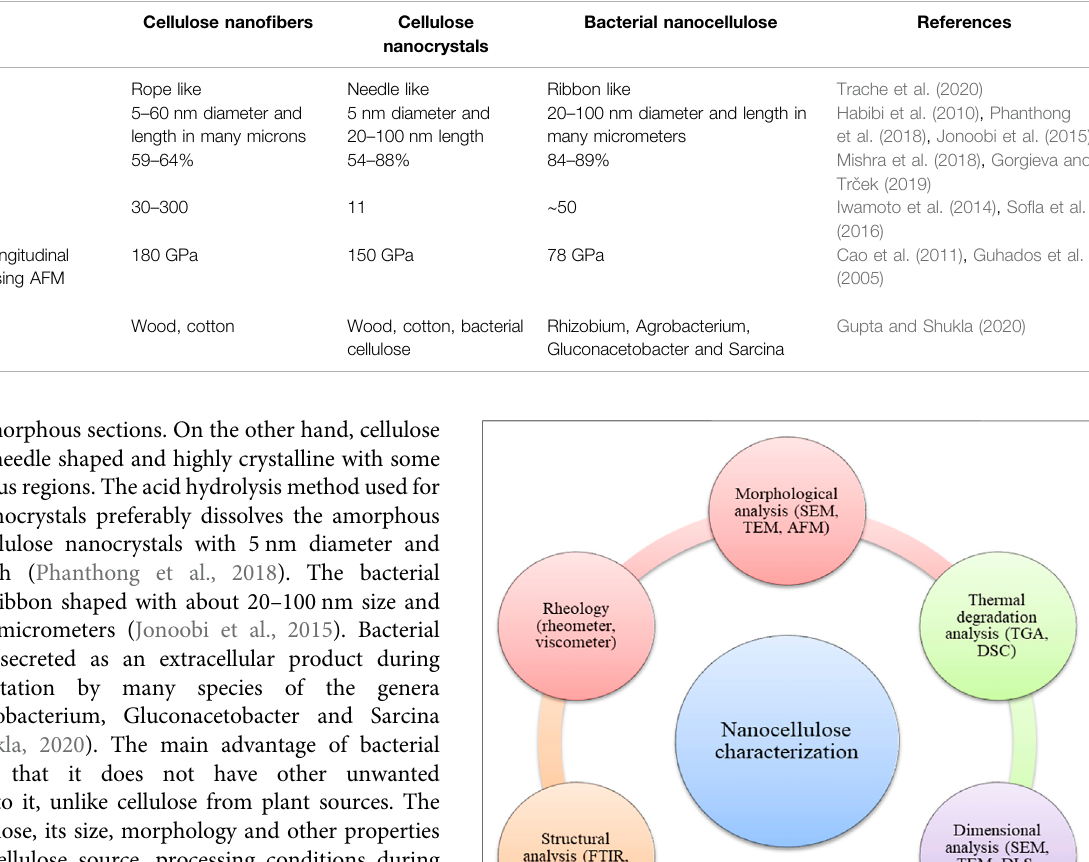
TABLE 1 | Comparison of different types of nanocellulose.